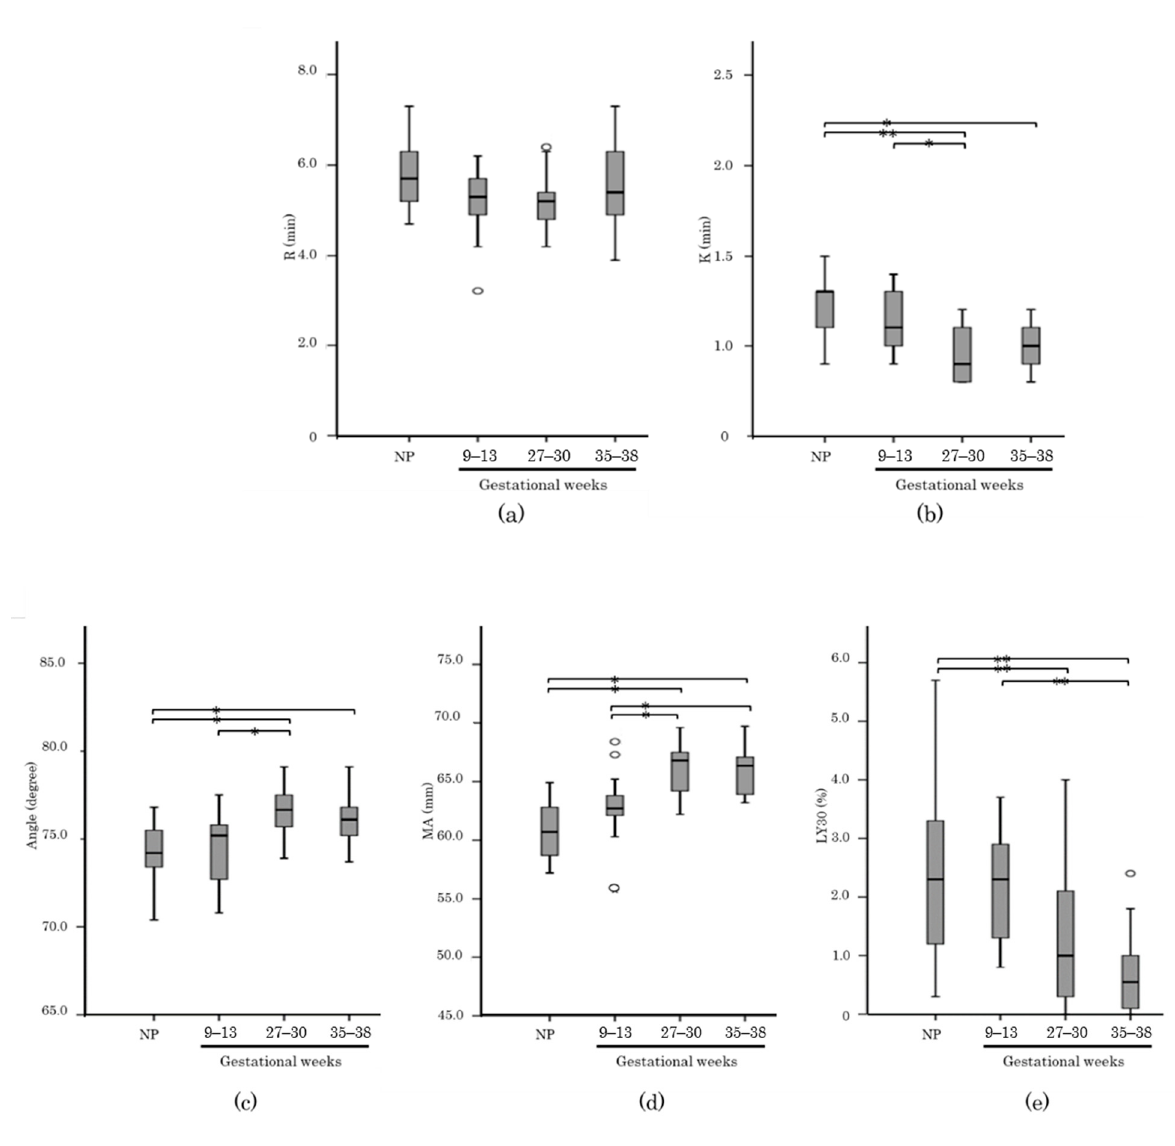
Figure 3. Box-and-whiskers plots showing the results of thromboelastographic parameters; R ( a ), K ( b ), Angle ( c ), MA ( d ), LY30 ( e ) in CK assays between pregnancy and non-pregnant woman (NP). The band inside the box shows the median. The Mann-Whitney test was performed to calculate p values (*: p < 0.05, **: p < 0.001).